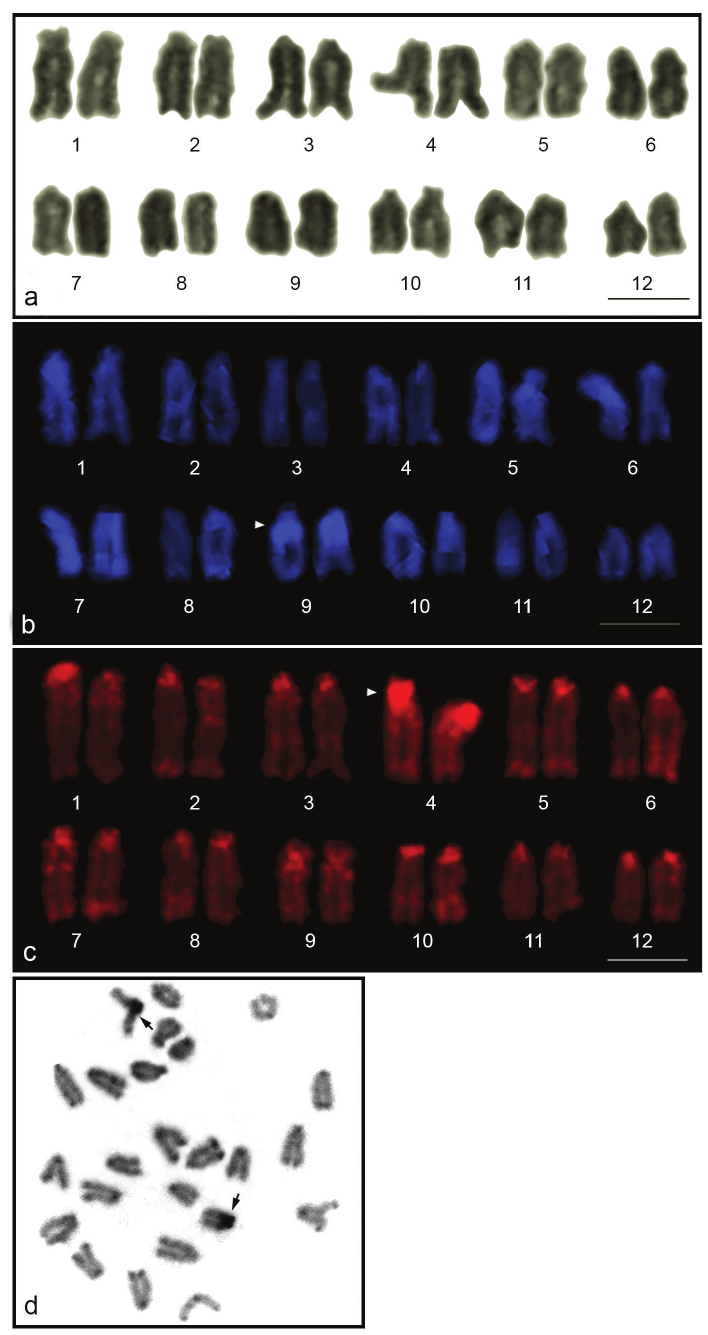
Figure 1. Giemsa-stained ( a ), DAPI-stained ( b ), PI-stained karyotype ( c ), and C-banded metaphase spread ( d ) of Monopterus albus . Arrowheads indicate the large DAPI-stained and large PI-stained regions. Arrows indicate C-positive heterochromatin blocks. Scale = 10